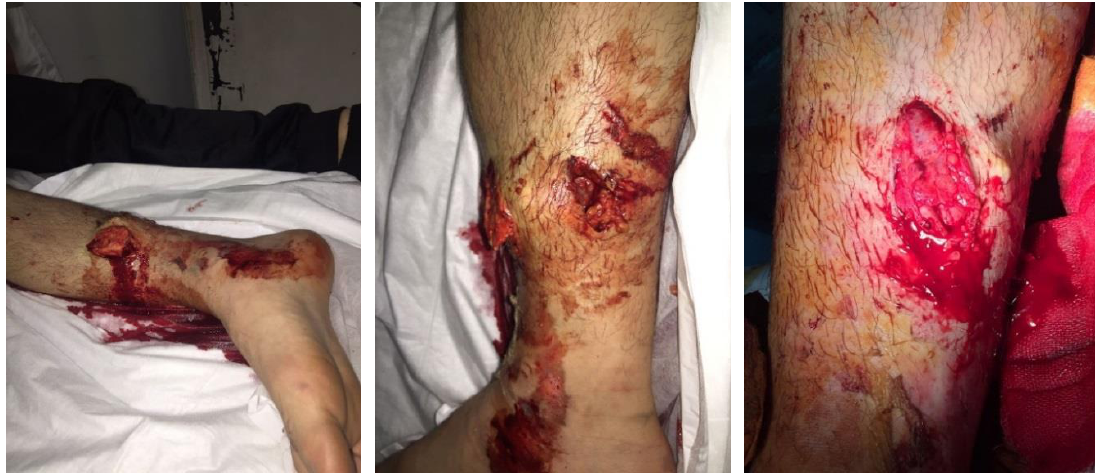
Figure 1. Degree of exposure of the fracture and soft tissue at the level of the right leg.